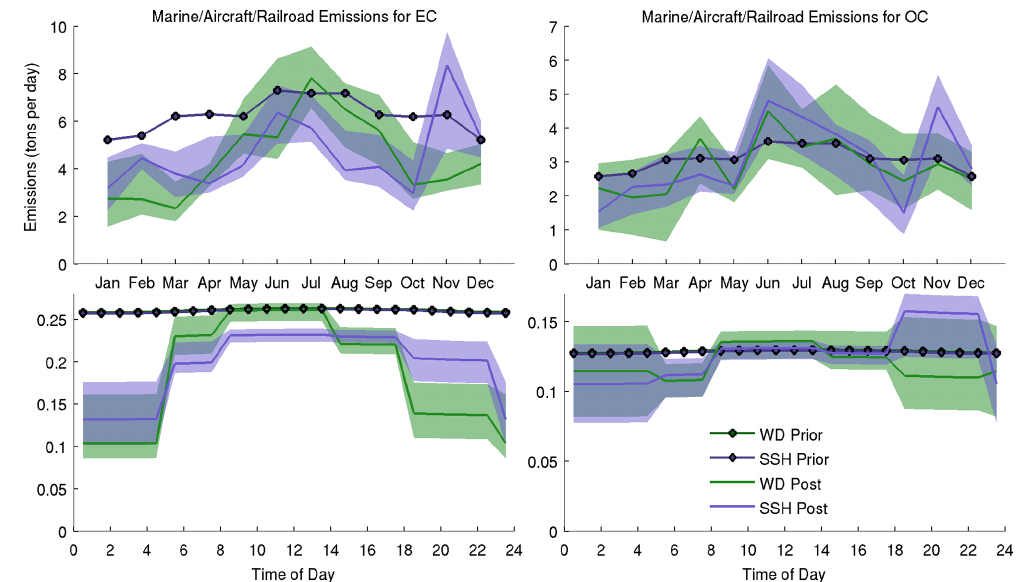
Figure 12. Monthly and diurnal temporal pattern of emissions of EC and OC for marine/aircraft/railroad (MAR) emissions by weekday and weekend for the St. Louis region, see Fig. 10.